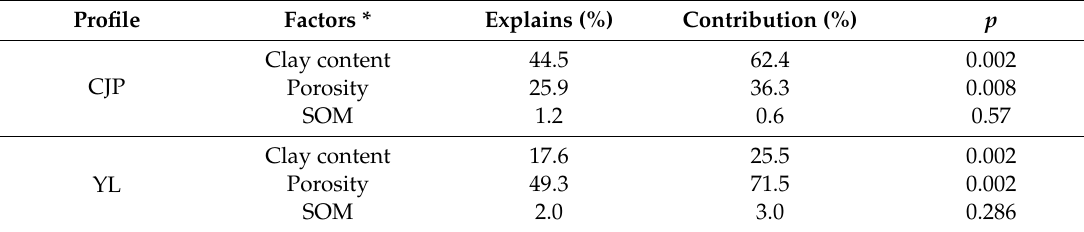
Table 1. Results of redundancy analysis (RDA) for the soil basic properties and soil hydraulic properties.